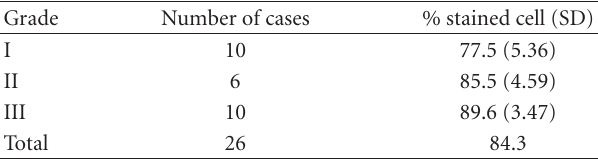
Table 1: The NUCKS positive staining in cells of invasive ductal carcinoma (in %) with relation to histological grading